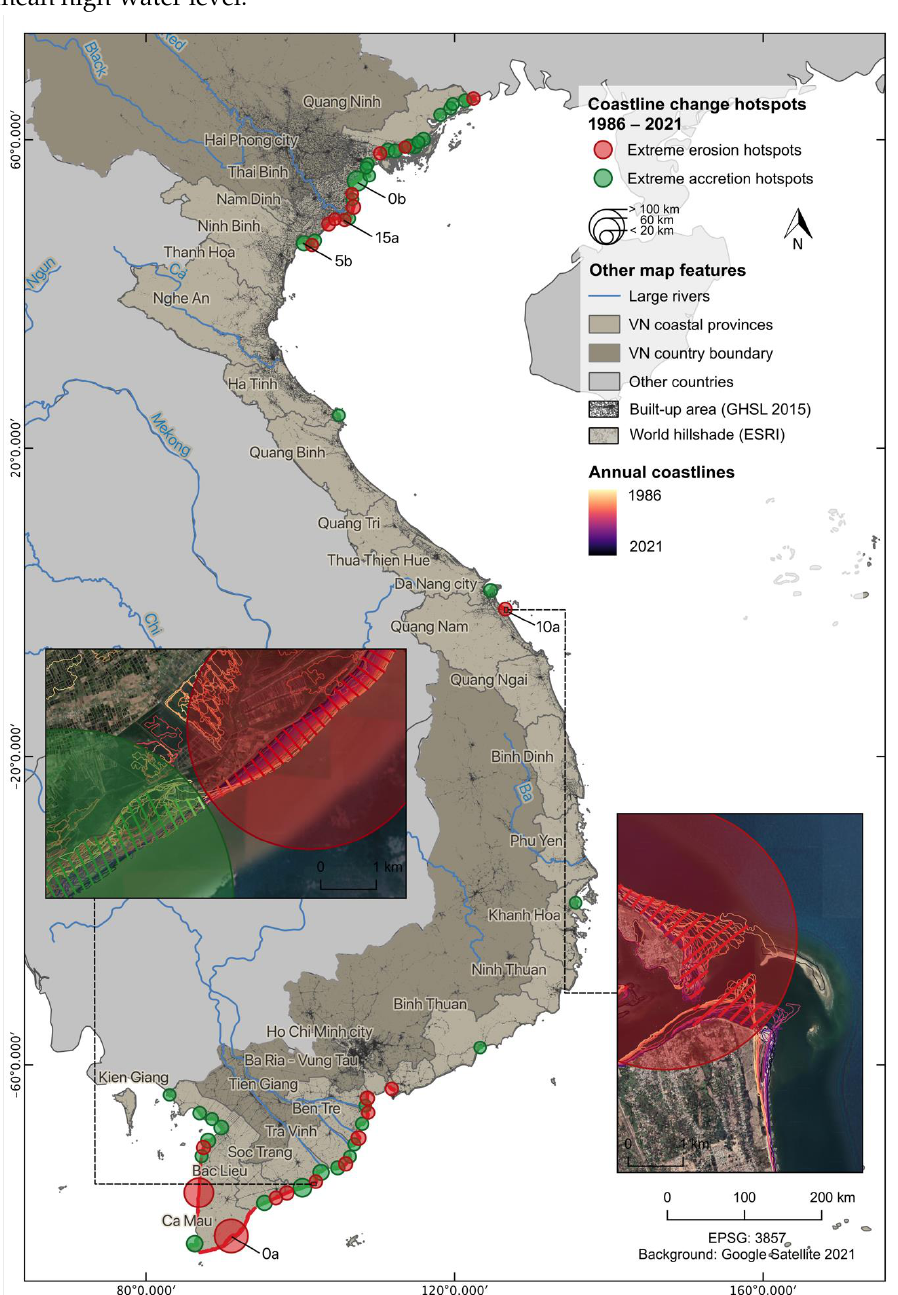
Figure 9. Coastline change hotspots in Vietnam from 1986 to 2021. Only the hotspots with extreme average erosion and accretion rates (>5 m/year) were selected. The size of the circle differs by the length of the affected coastal segment. The two zoom images additionally show the annual coastlines overlaid by the filtered hotspot transects and circles.